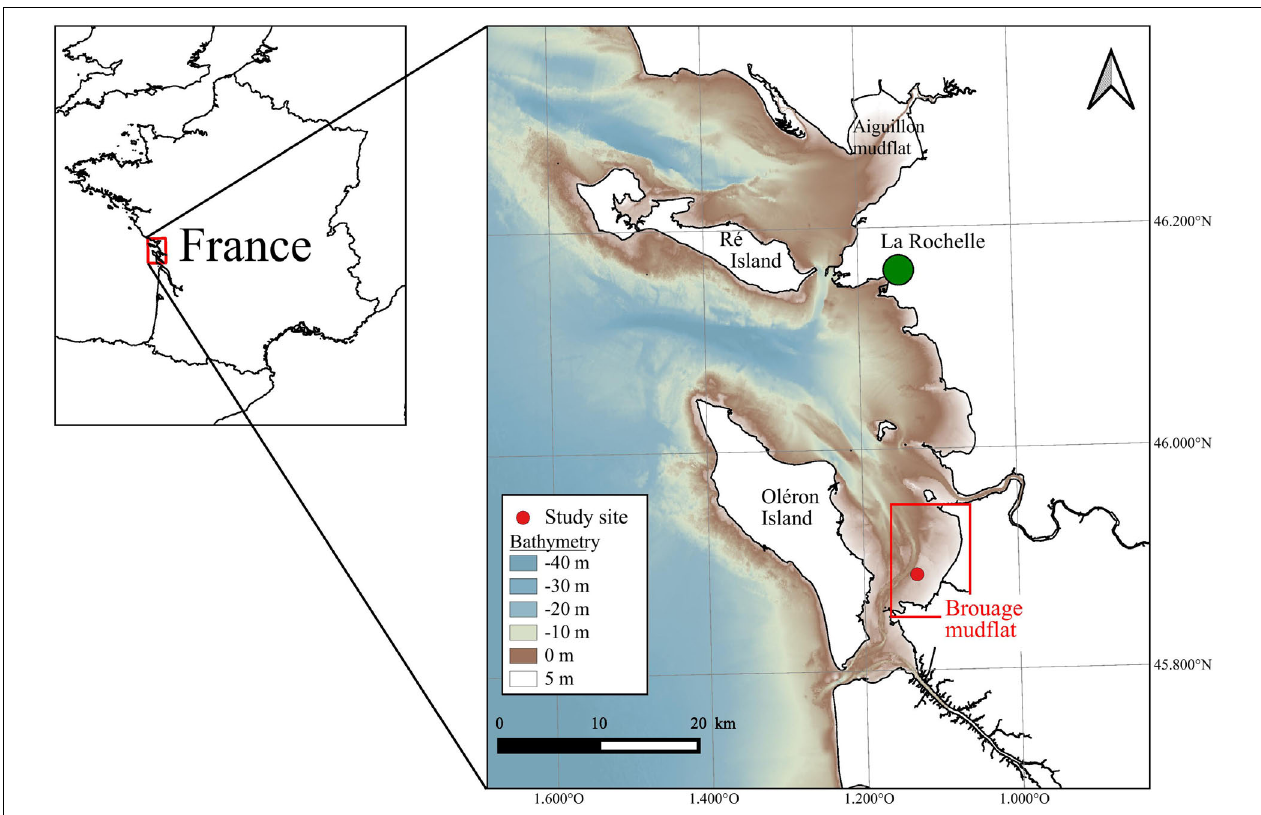
FIGURE 1 | The Pertuis Charentais, and the Brouage mudflat, France. The red point indicates the study site. Bathymetry is used in MARS-3D model (source: